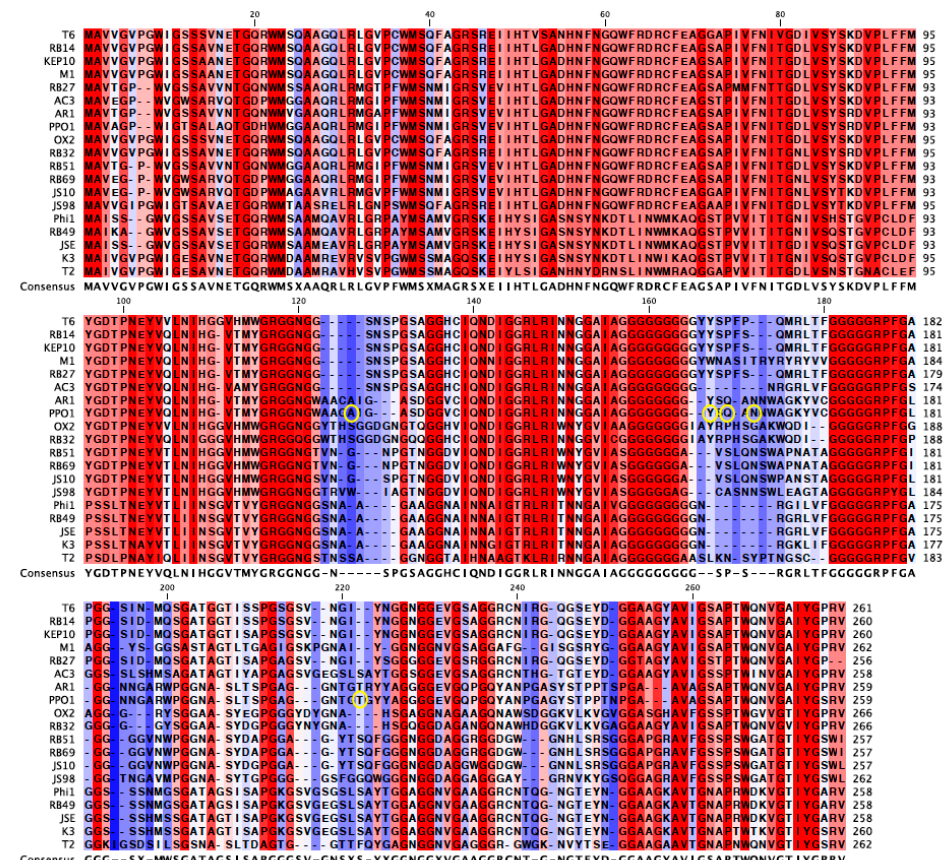
Figure 4. Gp38 amino acid sequence alignment of PP01 and its closest relatives. Amino acids in shades of red are highly conserved and amino acids in shades of blue are not conserved among the viruses. The shaded regions are the binding domains of the protein. The yellow circles indicate the mutated amino acids in the evolved populations.